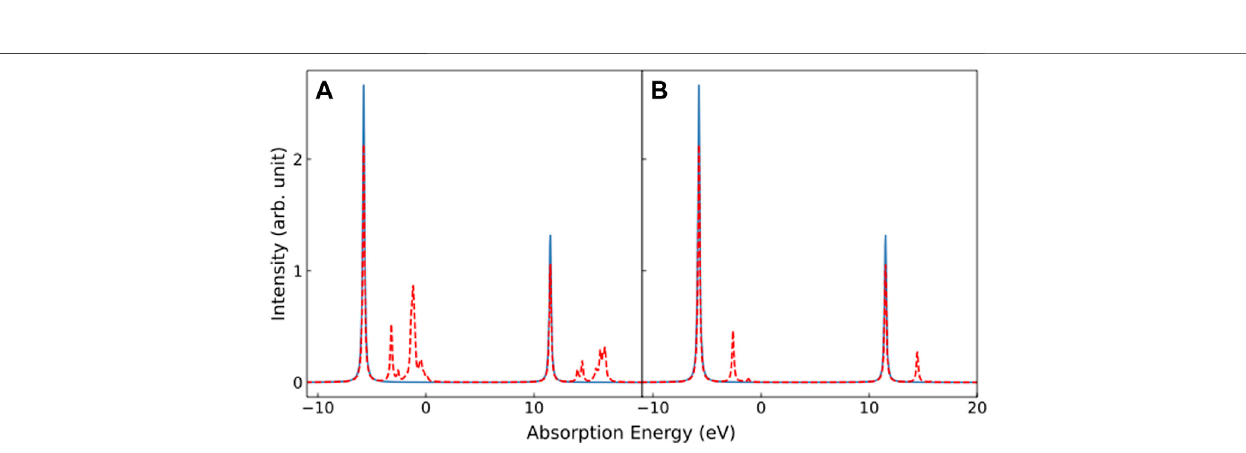
Frontiers in Physics |